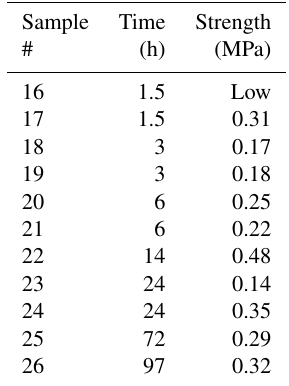
Table 3. Results from testing saline bond experiments at − 3 ◦ C and 12ppt.